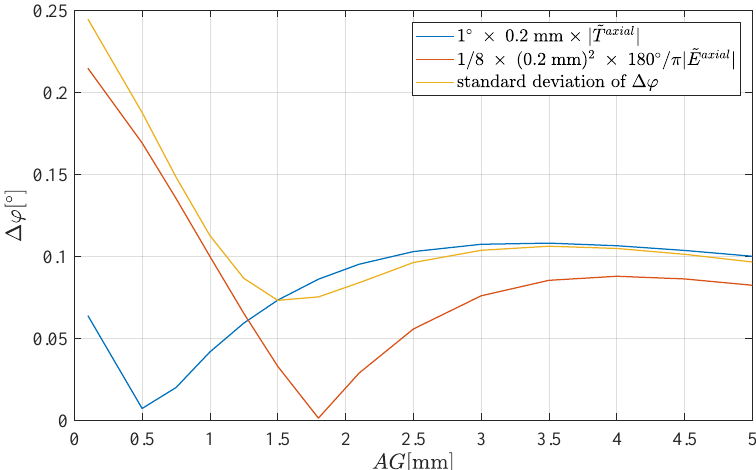
Figure 6. Simulated effects of statistical superposition of angle errors for a magnet as given in Section 3 with assembly tolerances according to Table 2 compared to the shape functions | ˜ T axial | and | ˜ E axial |